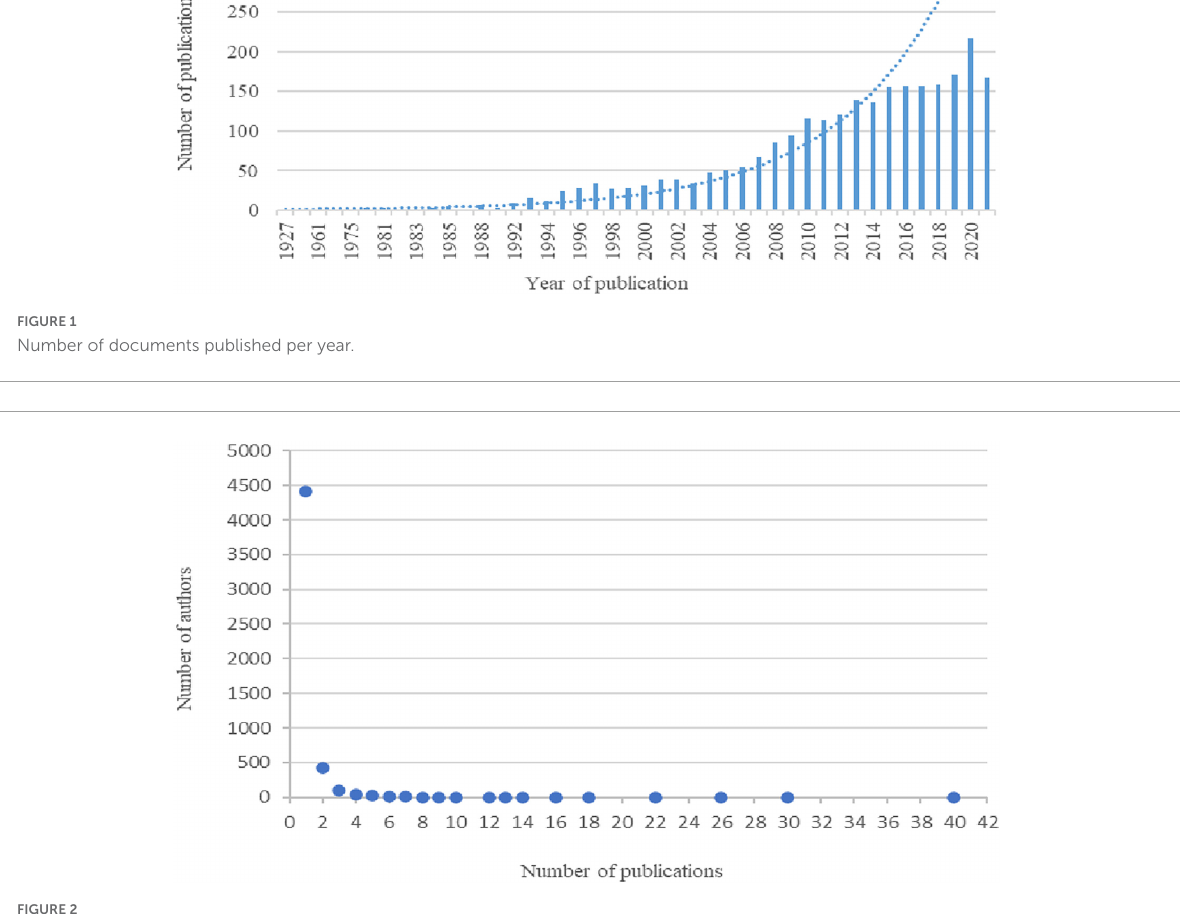
FIGURE2 Authors and number of published